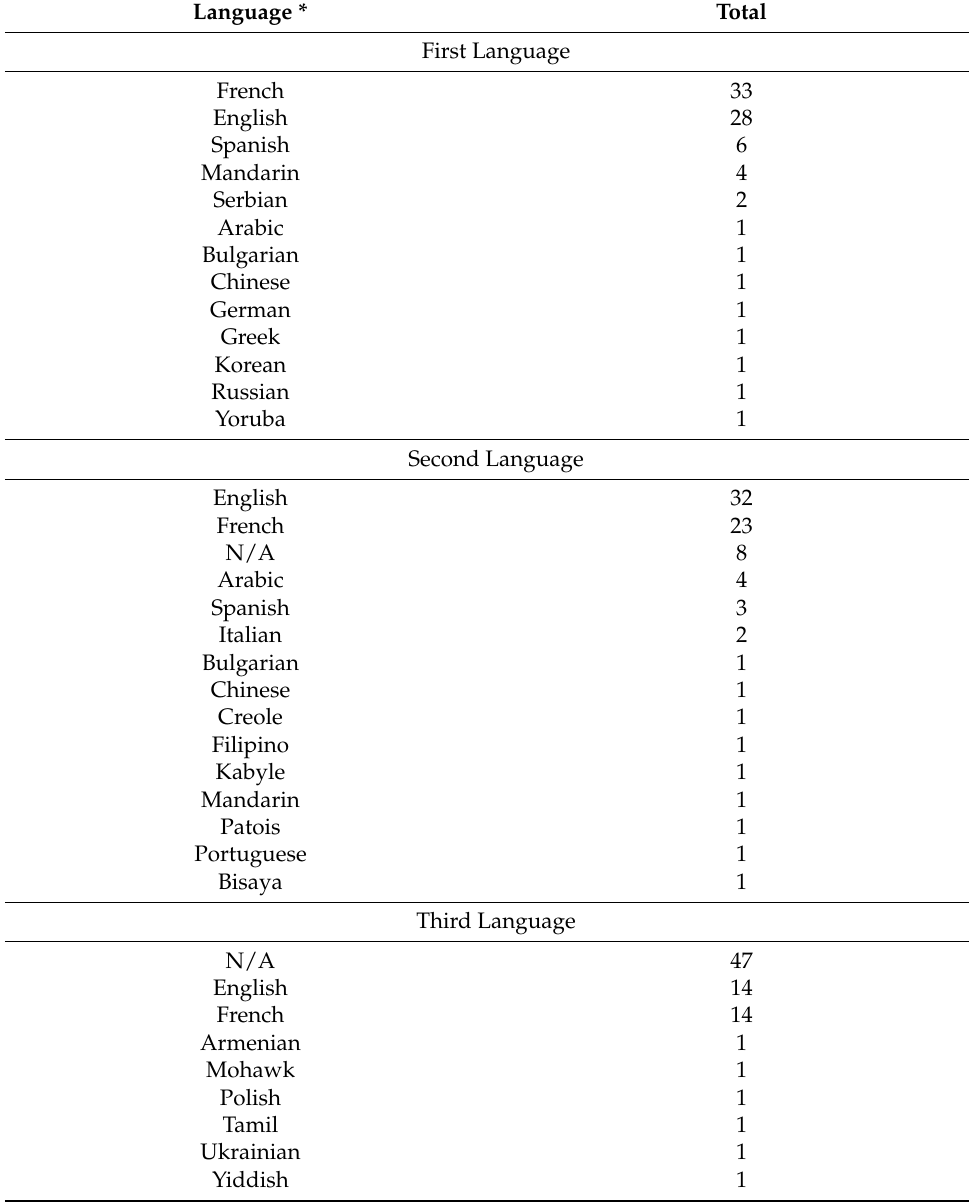
Table A1. Language frequencies for total